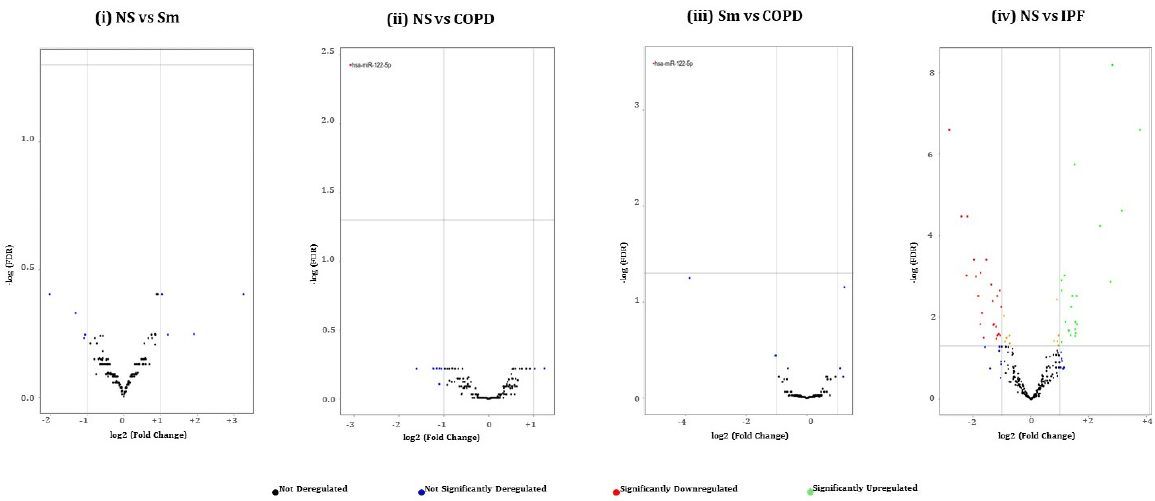
Figure 5. Volcano plots showing number and distribution of miRNAs from lung-tissue-derived exosomes. Volcano plots showing the relation between –log(FDR) (y-axis) vs. log2 (fold change) (x-axis) in the differentially expressed miRNAs amongst lung tissue derived exosomes from ( i ) healthy non-smokers (NS) vs. healthy cigarette smokers (Sm), ( ii ) healthy non-smokers (NS) vs. COPD patients (COPD), ( iii ) healthy cigarette smokers (Sm) vs. COPD patients, and ( iv ) healthy non-smokers (NS) and IPF patients (IPF). To avoid the overlap between the miRNA names, an unlabeled graph for this comparison is used. However, a detailed account of each of the differentially expressed miRNAs is provided in Figure 7.